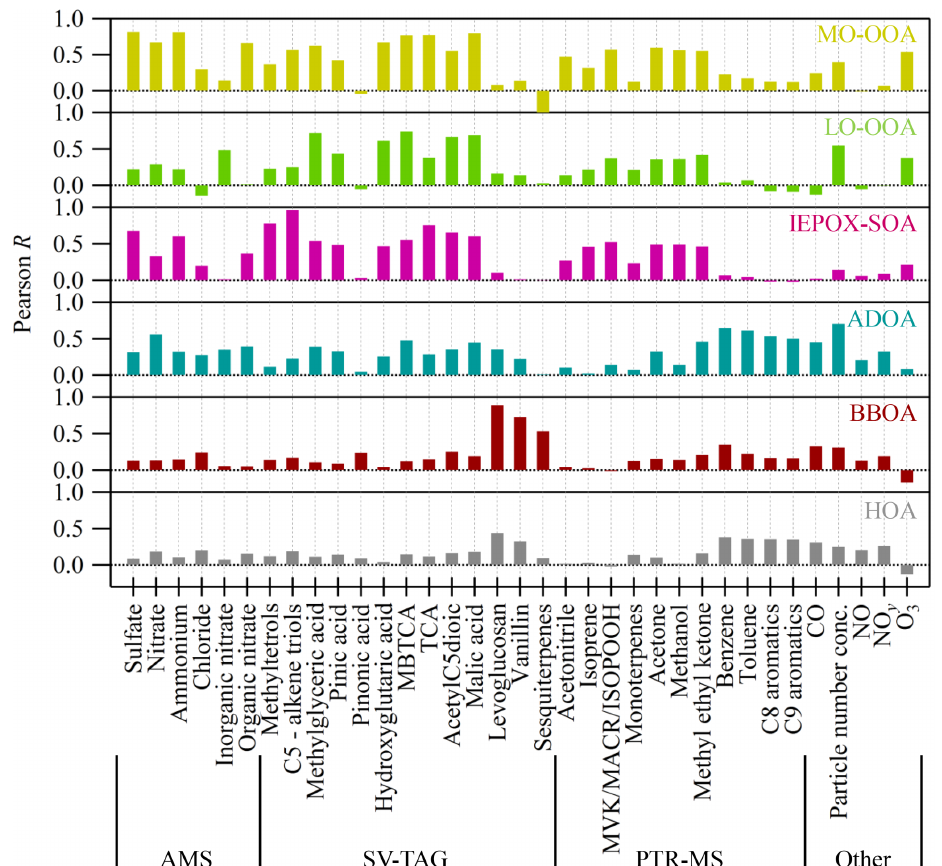
Figure 5. Column plot of Pearson R correlations between the loading of each PMF factor and values of selected measurements at T3. Abbre- viations include tricarballylic acid (TCA), methyl-butyl-tricarboxylic acid (MBTCA), methyl vinyl ketone (MVK), methacrolein (MACR), and isoprene hydroxyhydroperoxides (ISOPOOH). SV-TAG measurements refer to particle-phase concentrations. Isomers could not be dis- tinguished by PTR-ToF-MS measurements; C 8 and C 9 aromatics include the xylene and trimethylbenzene isomers, respectively.